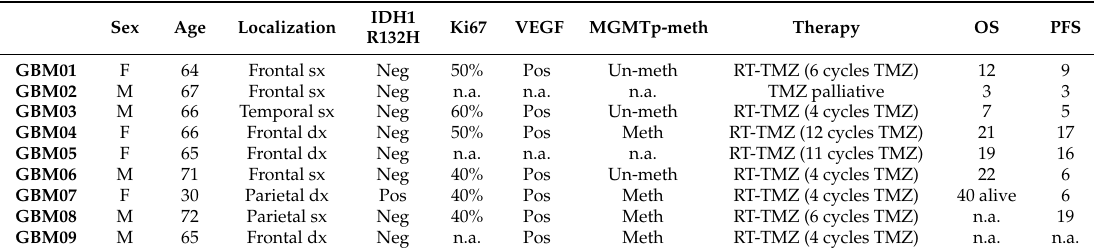
Table 1. GBM patient characteristics.